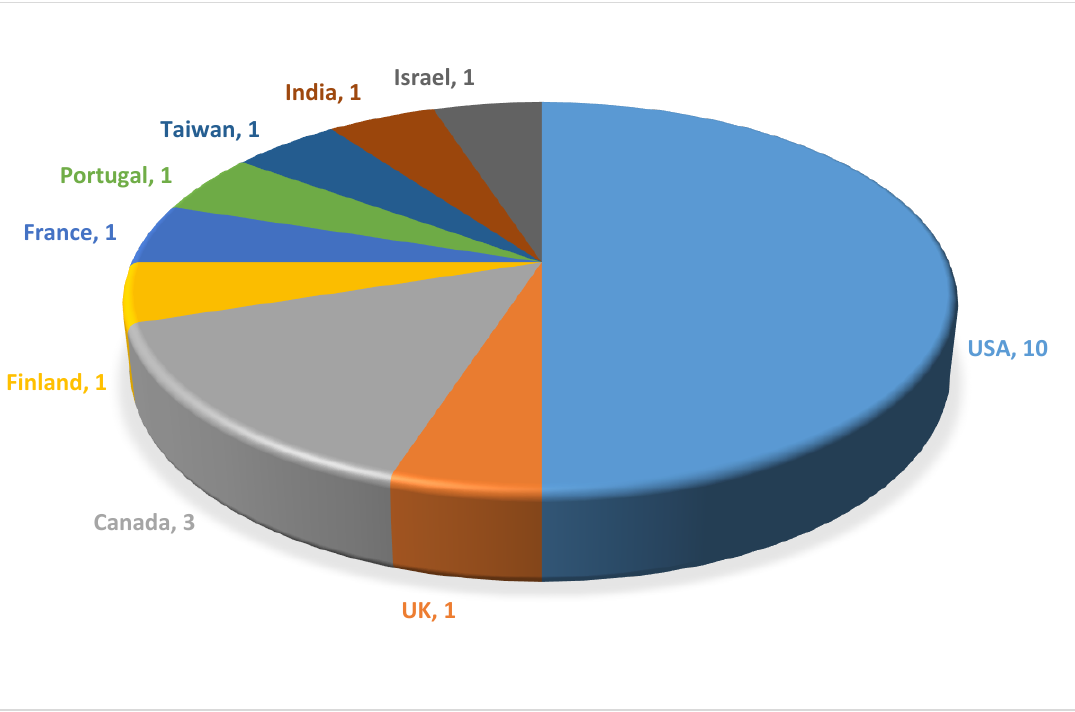
Figure 5. Distribution of SeCS suppliers worldwide.